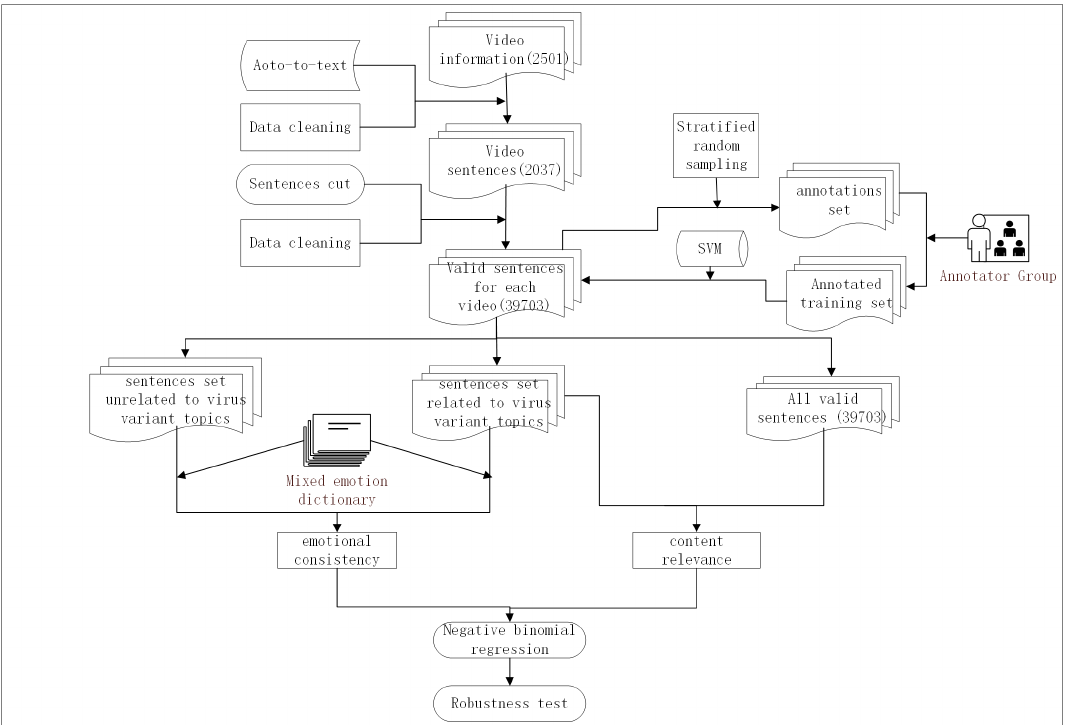
Figure 2. Research